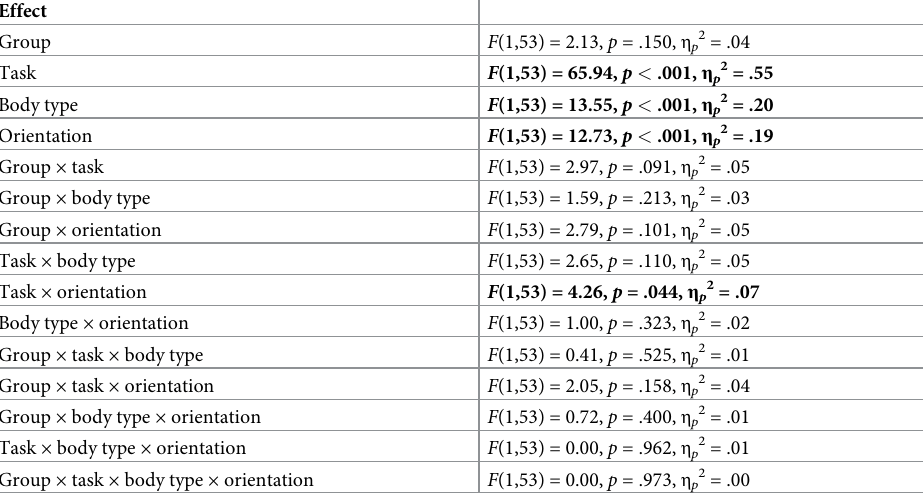
Table 4. Feet IAs dwell time proportion comparisons.